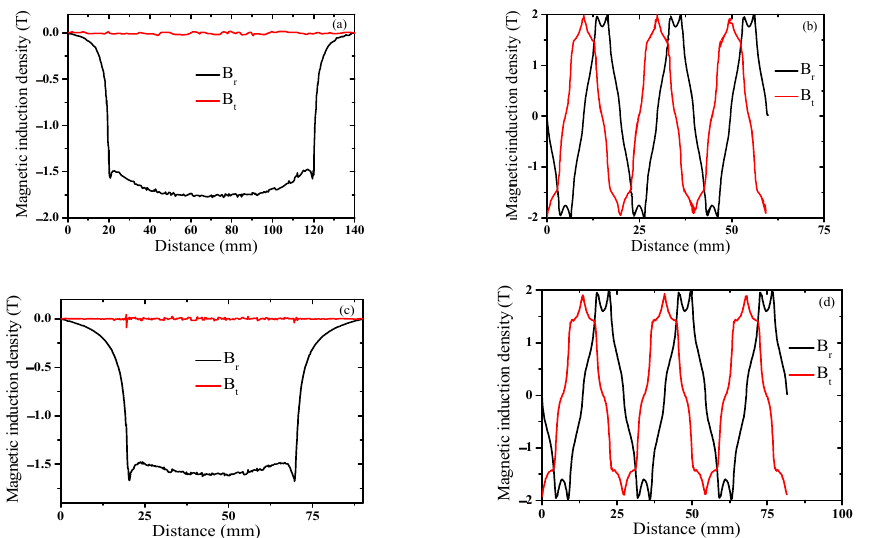
Formula (7), which is comparable to the simulated results of 1.4 T by Yamada et al. [20], since they use N38 permanent magnets.